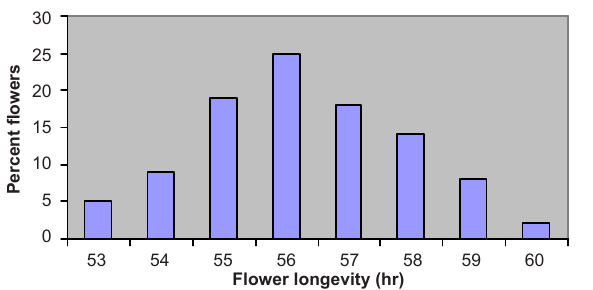
Figure 3. Frequency distribution of flower longevity in Sarpagandha